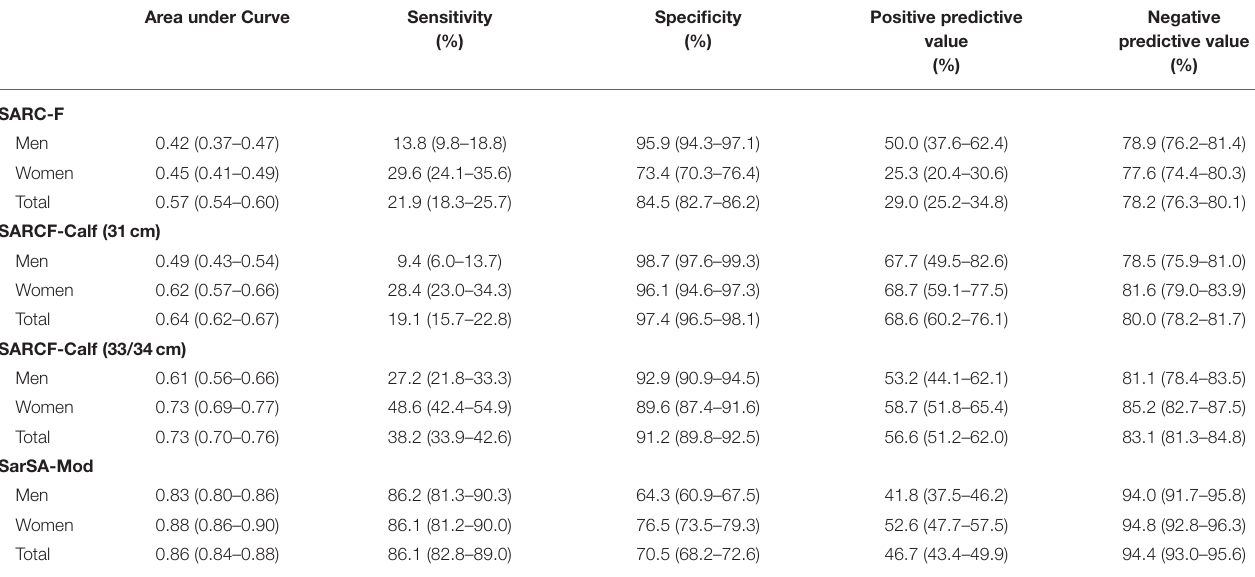
TABLE 4 | Comparison between the screening methods; SarSA-Mod, SARC-F, SARCF-Calf (31cm), and SARCF-Calf (33/34cm). Area under Curve Sensitivity Specificity (%)